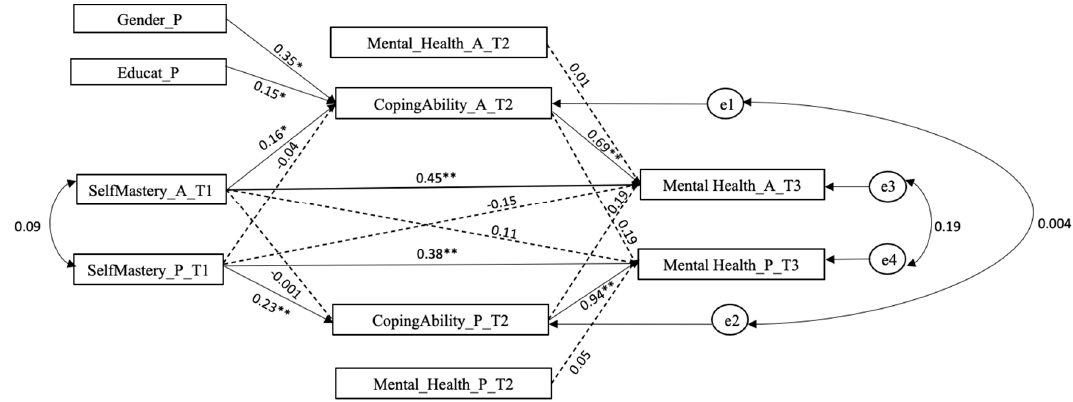
Figure 2. The estimated Actor-Partner Interdependence Model’s extended Mediation (APIMeM). Note: SelfMastery = Self-Mastery; CopingAbility = perceived coping ability to manage event-related stress; Mental_Health = Mental Health; A = adolescent; p = parent. Educat = parents’ level of education based on the ISCED classification [20]. Plain lines showed significant paths, dotted lines non-significant paths. * p < 0.05; ** p < 0.01. Source of the data: SHP.